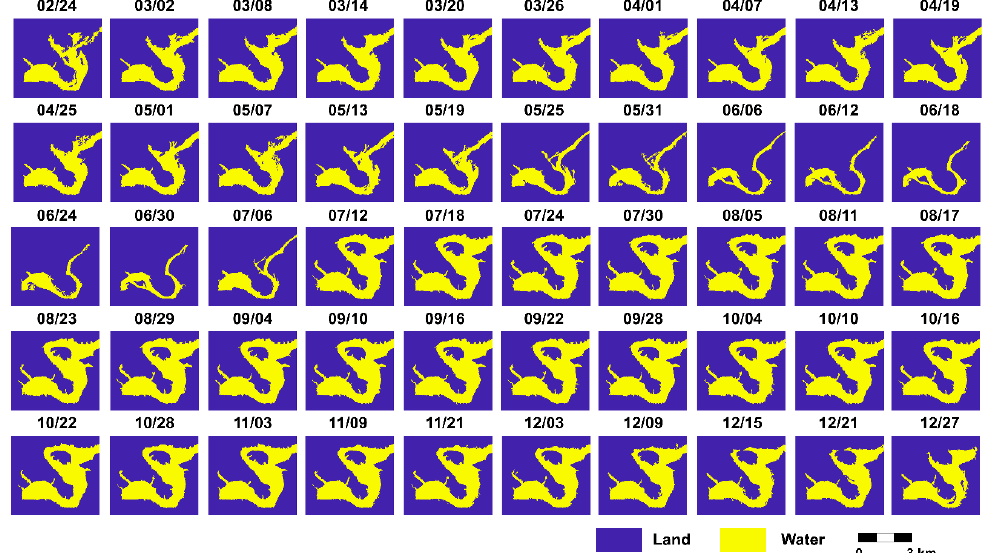
Figure 9. Intensity images of ( a ) Sentinel 1-A (2017/03/20) and ( b ) Sentinel 1-B (2017/03/26), which covers the Hwanggang Reservoir (red box).